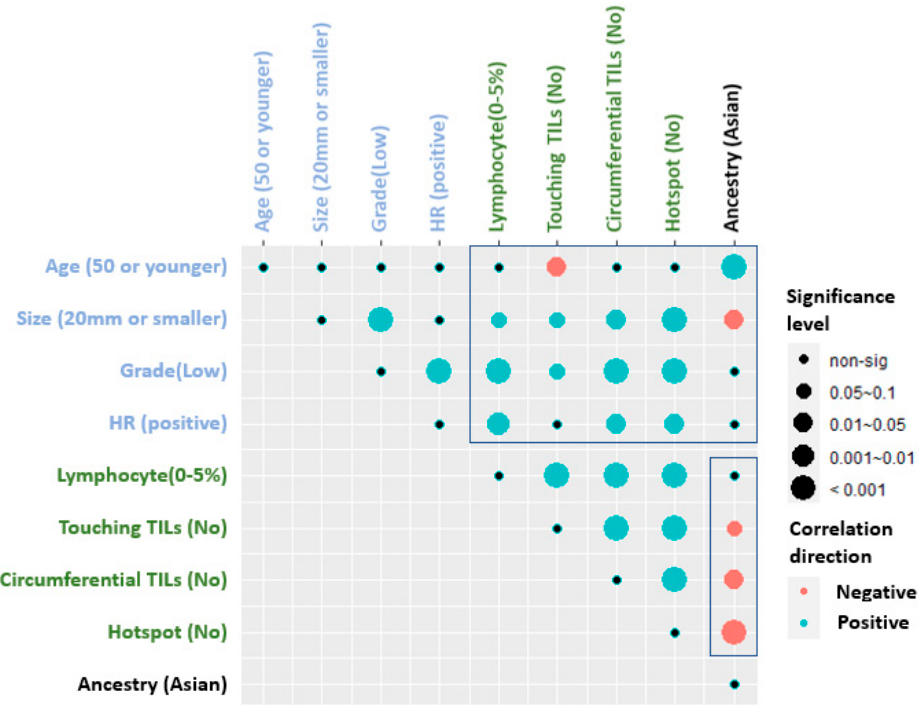
Figure 1. Correlation analysis of tumor-infiltrating lymphocytes (TILs) assessments with clinical and histologic parameters. The dependence of each pair was evaluated by Fishers exact test, and adjusted p (FDR) = 0.1 was applied to 36 pairs; p -value was adjusted using Bonferroni-Holm procedure; Blue and red circles represent positive and negative correlations, respectively; Significance levels were shown based on the size of the circles.